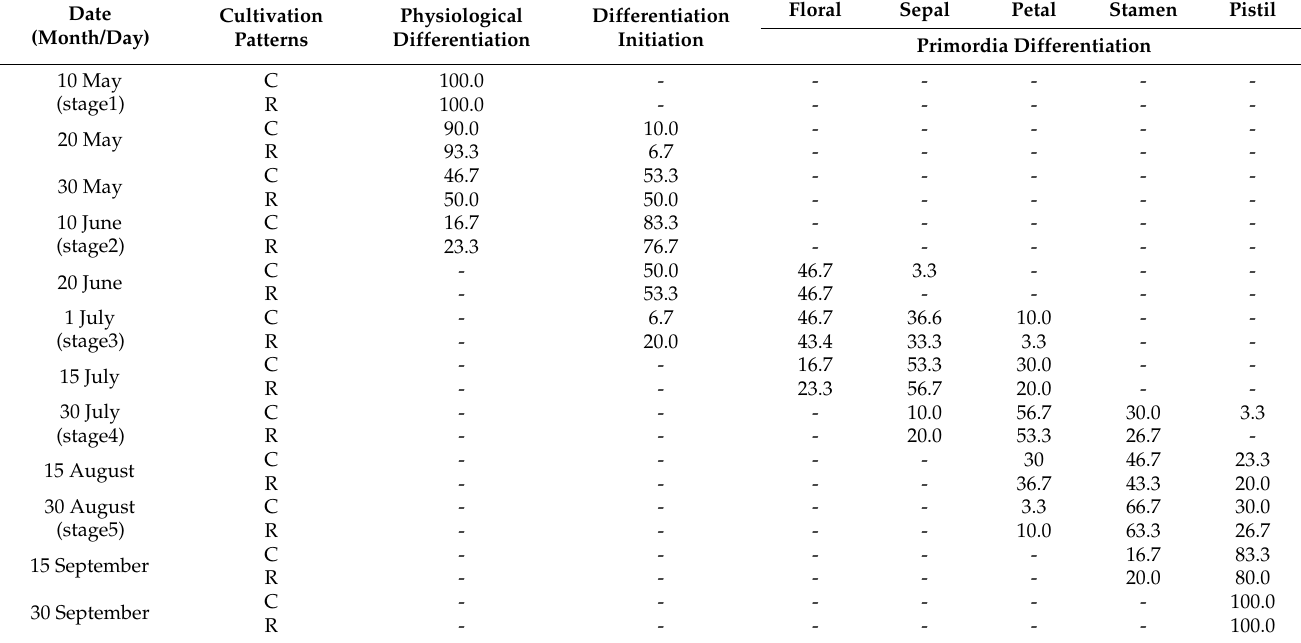
Table 1. Flower bud differentiation stages of ‘Manaohong’ and their percentage (%) in the ob- served